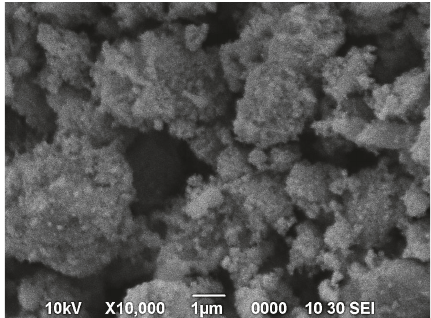
Figure 4: SEM micrograph of the zirconium-based ferromagnetic